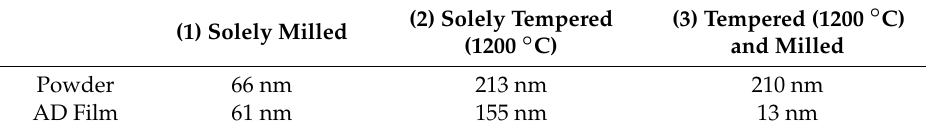
Figure 1. X-ray diffraction (XRD) patterns of pretreated GDC10 powders used for aerosol deposition: ( a ) complete 2 Θ range from 20° to 80° and ( b ) (111) reflection at 2 Θ = 28.5° (2 Θ range from 28.3° to 28.8°). Note: GDC = gadolinium-doped ceria.